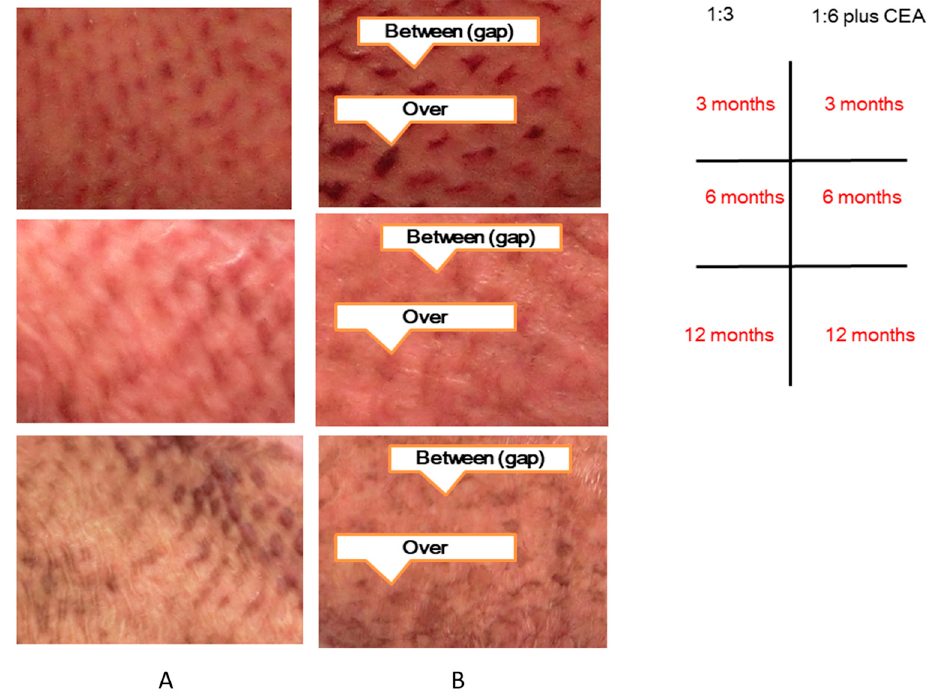
Figure 2. Measurement points of the gap 1:6 gap mesh plus CEA or over 1:6 mesh plus CEA ( A ) and 1:3 mesh ( B ).